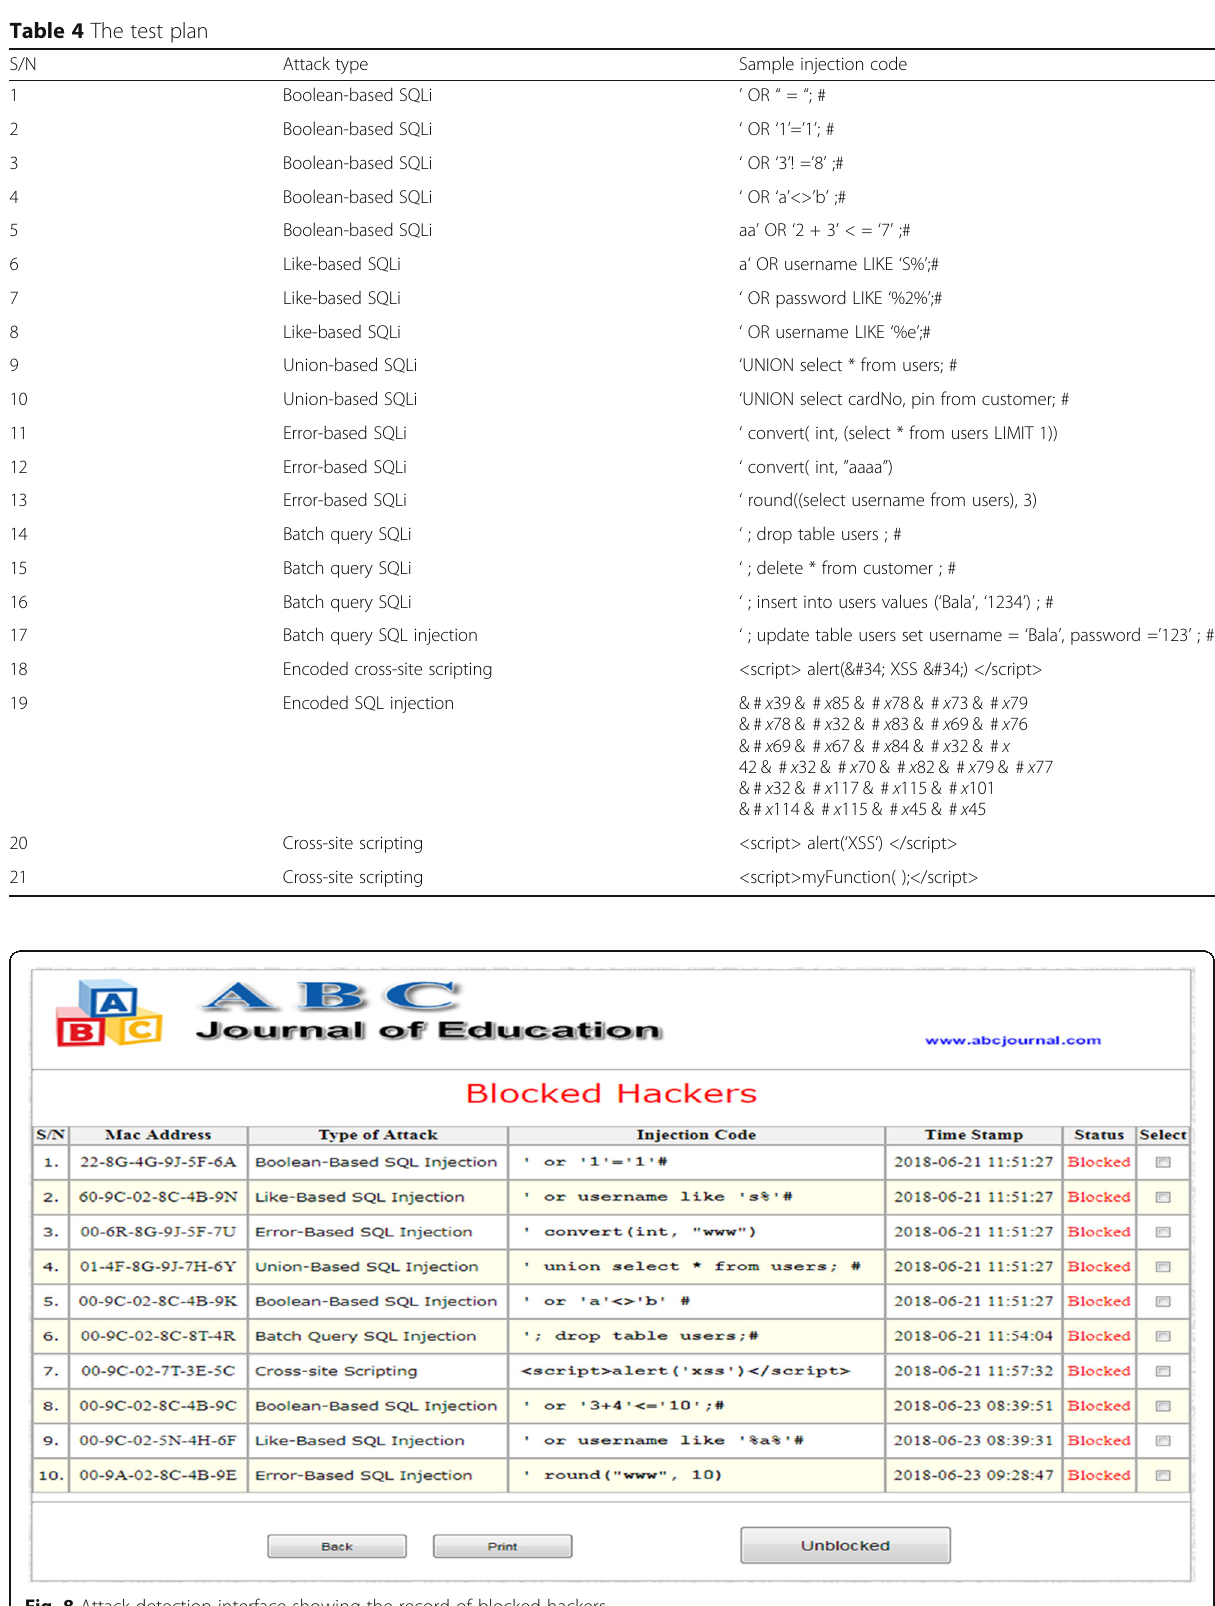
Fig. 8 Attack detection interface showing the record of blocked